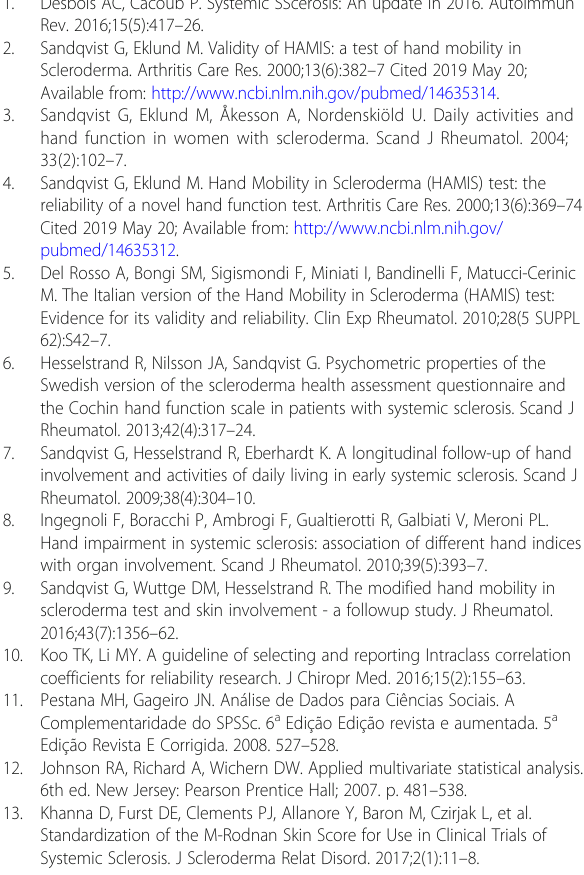
Table 6 Intraobserver and interobserver reliability for HAMIS-Br factors 1 and 2 Factor ICC Intraobserver ICC